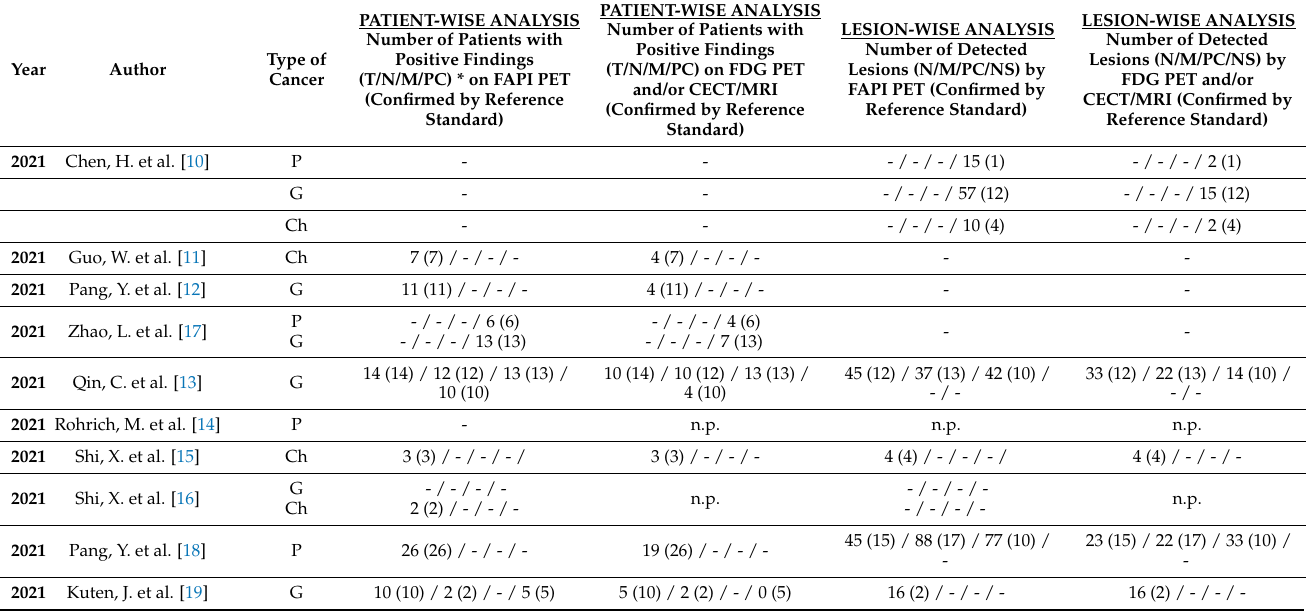
Table 4. Yield FAPI vs. FDG PET and/or CECT/MRI; patient-wise and